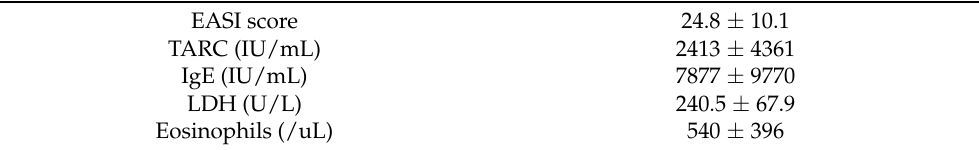
Table 2. Clinical and laboratory data of AD